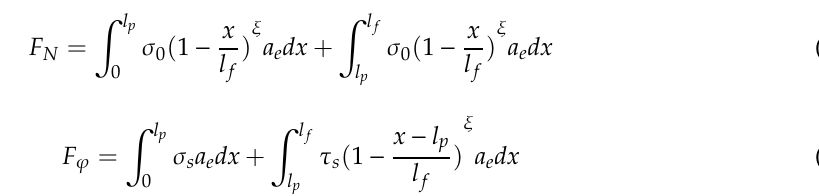
Figure 7. Stress model of the contact interface.